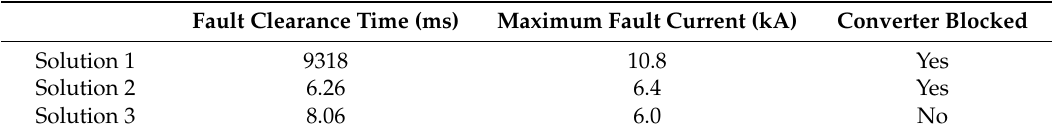
Table 2. Key quantities of the system with different